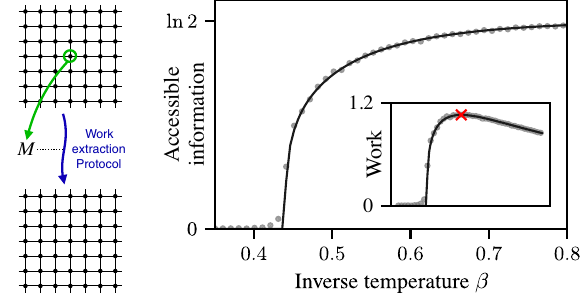
FIG. 7. Thermodynamics of information on a 2D Ising model. Left: A measurement M is made of the state of a single spin (green) and then used to drive the system while extracting work (blue). ϕ G ; M Þ increases with Right: The accessible information I acc ð X ≈ 0 . 44 [gray circles inverse temperature after the critical value β c from Monte Carlo simulations, black line from closed-form expression in Eq. (56)]. The inset shows the bound on extractable ϕ G ; M Þ = β , which peaks at β ≈ 0 . 547 (red work, I acc ð X